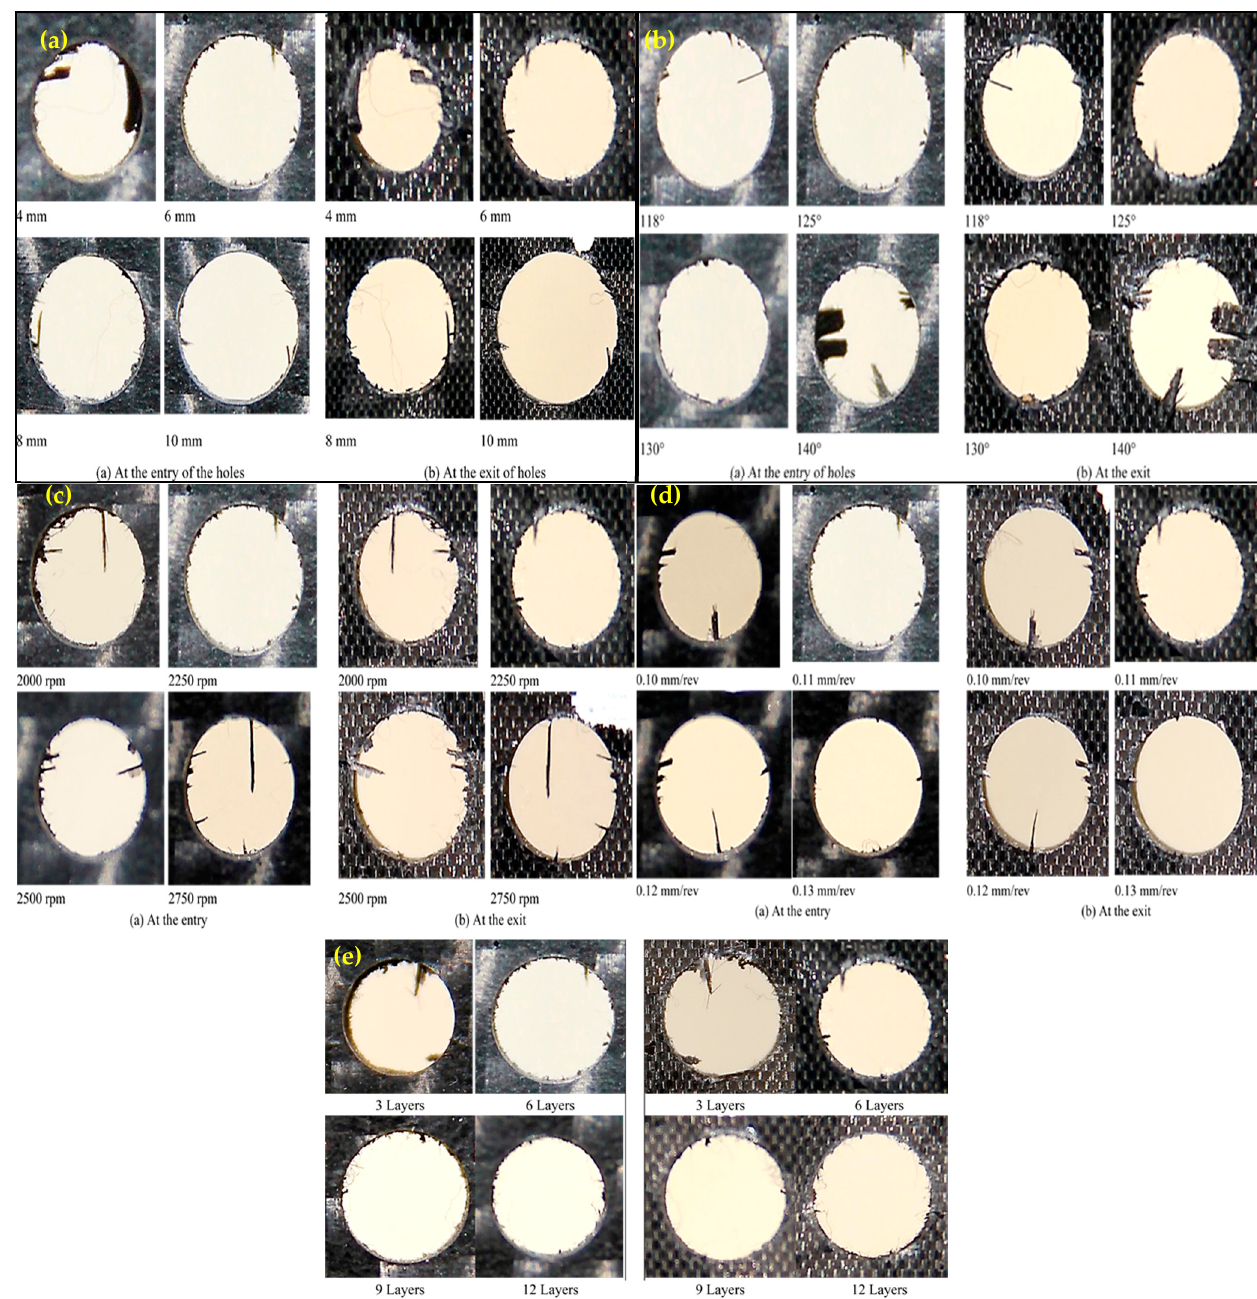
Figure 10. ( a ) Influence of drill bit diameter at the entry and exit of drilled holes (point angle of 125 ◦ , 6 Scotch tape layers, spindle Scheme 2250. Rpm, and feed rate of 0.11 mm/rev), ( b ) Influence of point angle at the entry and exit of drilled holes (drill bit diameter of 6 mm, 6 Scotch tape layers, spindle speed of 2250 rpm, and feed rate of 0.11 mm/rev), ( c ) Influence of spindle speed at the entry and exit of drilled holes (drill bit diameter of 6 mm, point angle of 125 ◦ , 6 Scotch tape layers, and feed rate of 0.11 mm/rev), ( d ) Influence of feed rate on the entry and exit of drilled holes (drill bit diameter of 6 mm, point angle of 125 ◦ , 6 Scotch tape layers, and spindle speed of 2250 rpm), ( e ) Influence of the number of Scotch tape layer at the entry and exit of drilled holes (drill bit diameter of 6 mm, point angle of 125 ◦ , spindle speed of 2250 rpm, and feed rate of 0.11